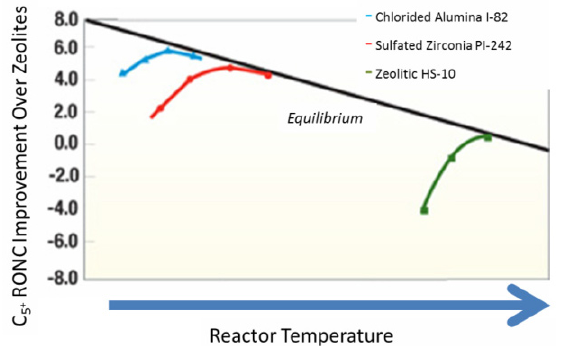
Figure 8. Activity vs . temperature for different commercial catalysts from UOP